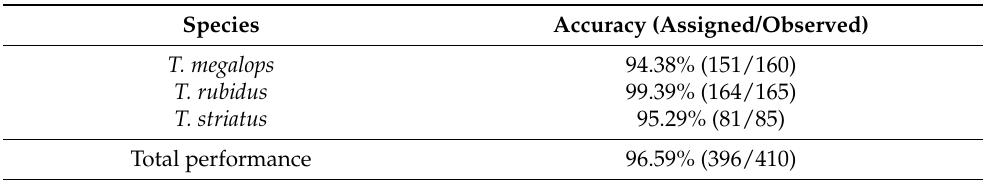
Figure 7. Factor map of the discriminant factors (DF) showing shape divergence of Tabanus megalops (red), T. rubidus (green), and T. striatus (blue). Together, the two DF represent 100% of the total discriminant space: 85% for DF1 (horizontal axis) and 15% for DF2 (vertical axis). Table 3. Validated classification based on the wing shapes of Tabanus megalops , T. rubidus , and T. striatus .